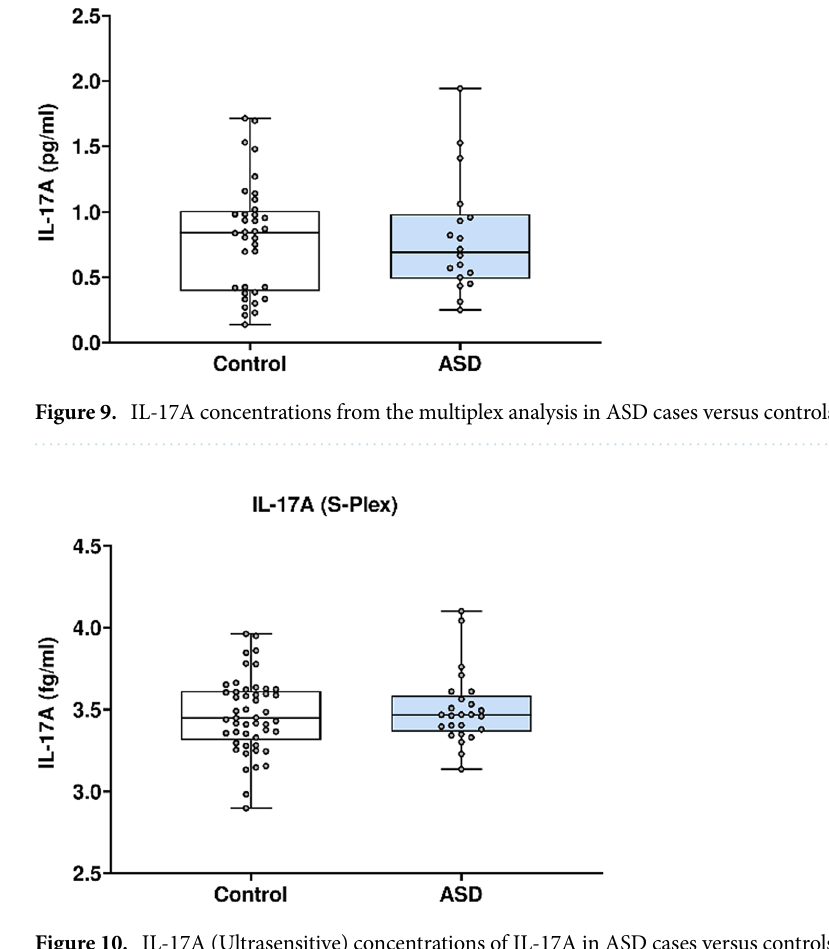
Figure 10. IL-17A (Ultrasensitive) concentrations of IL-17A in ASD cases versus